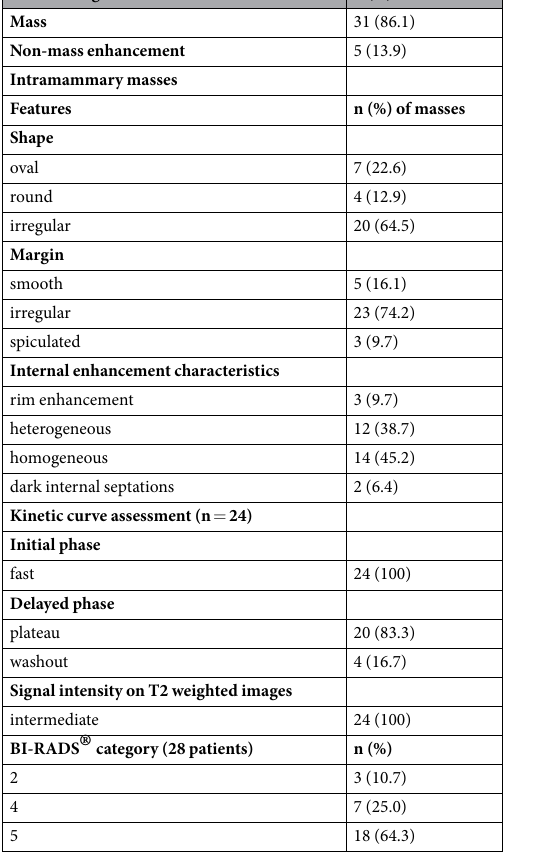
Table 7. MRI findings in